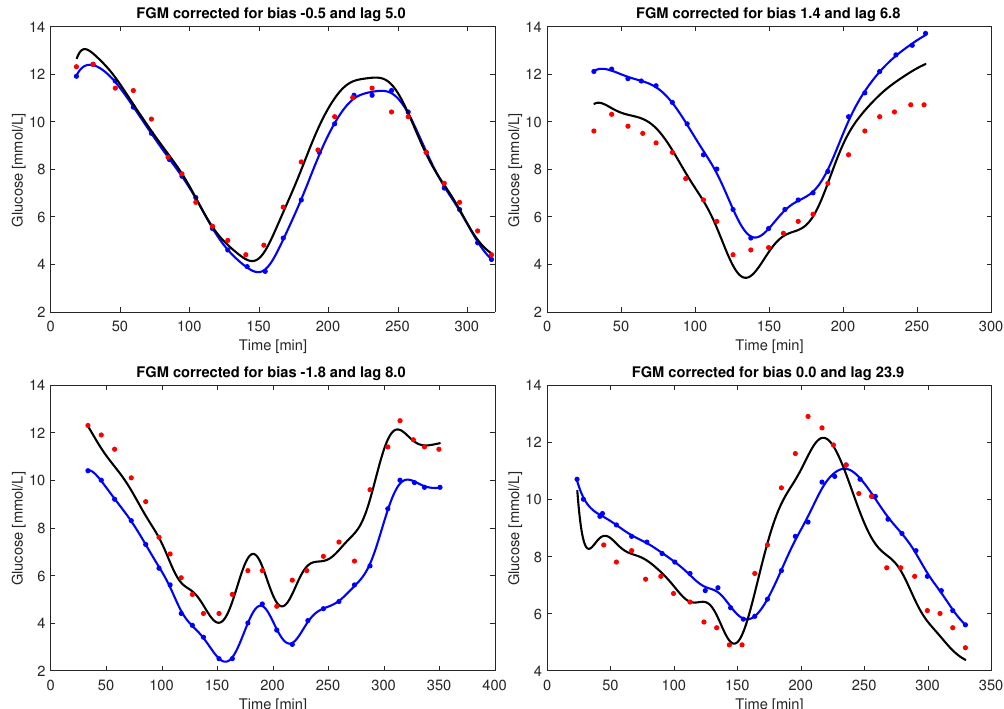
Figure A1. Bias and lag correction of the same data as shown in Figure 1. Here, only the FGM ( blue ) points, a bias and a lag are used as inputs to the smoother, and the black line shows the corrected signal. Red points are SMBG measurements. We see that the bias and lag correction brings the corrected FGM signal close to the SMBG measurements in all cases seen here.